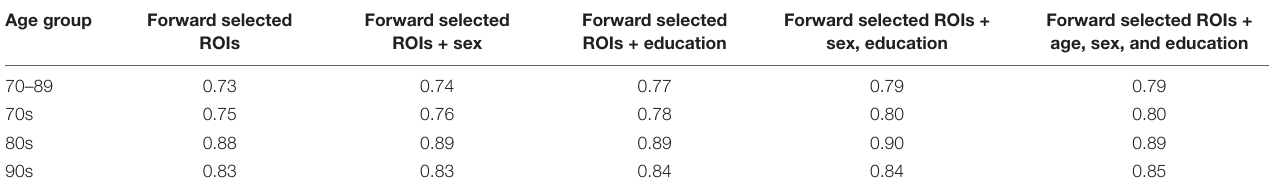
FIGURE 3 | Receiver operating characteristic curves show better TCP predictive performance in whole brain model. Top: ROC curves with area under the curves (AUC) displayed for (A) entire NACC sample (ages 70–89), (B) a priori cingulate regions in all age groups, and (C) network/whole-brain forward-selected ROIs across all age groups. Bottom: Permutation analyses where the labeling of TCP vs. non-TCP was shuffled 10,000 times in (D) NACC 70 year olds, (E) NACC 80 year olds, and (F) The 90 + Study 90 year olds. Red dotted lines represent AUC’s for a priori cingulate ROIS reflected in (B) and blue solid lines represent AUC for network/whole-brain forward-selected ROIs reflected in (C) . AUC: Area under the curve, 70s: NACC 70 year olds, 80s: NACC 80 year olds, 90s: The 90 + Study 90 year olds. TABLE 4 | Effects of age, sex, and education on AUC